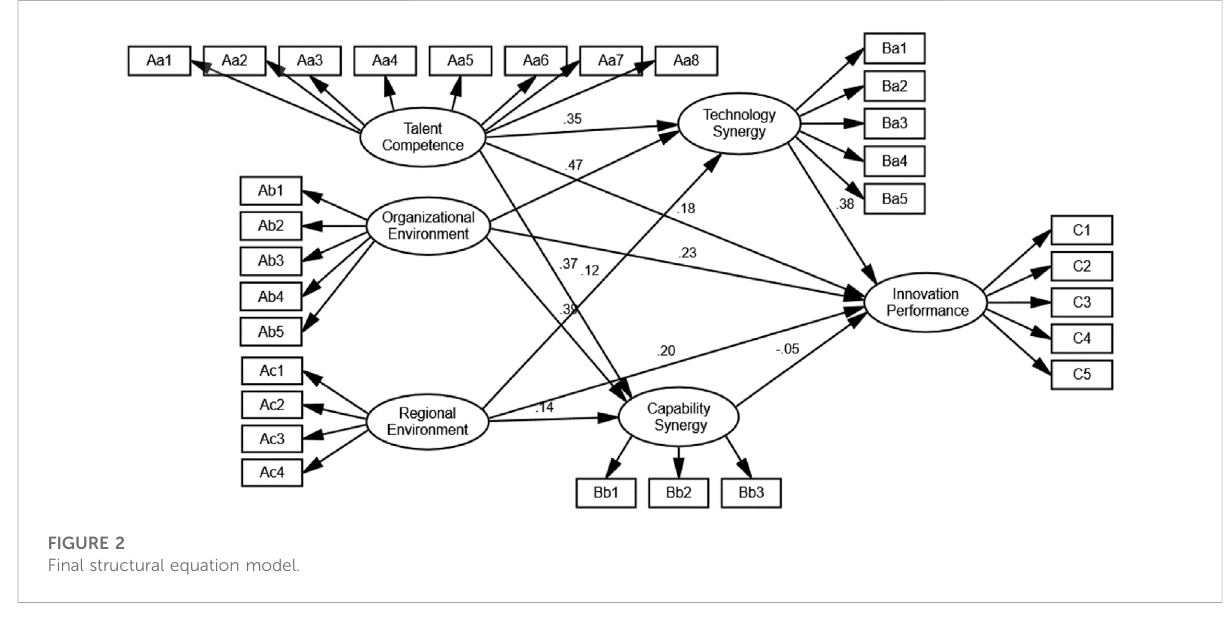
FIGURE 2 Final structural equation model.